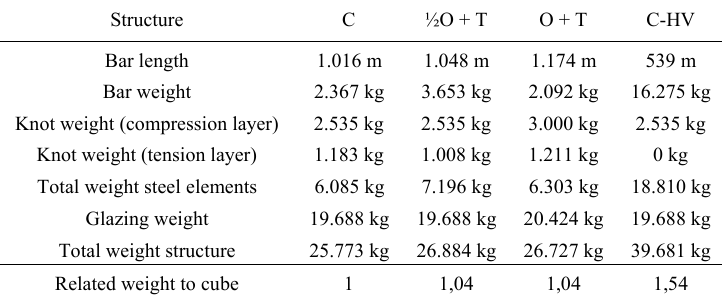
octahedron+tetrahedron (½O+T) and octahedron+tetrahedron (O+T) both on